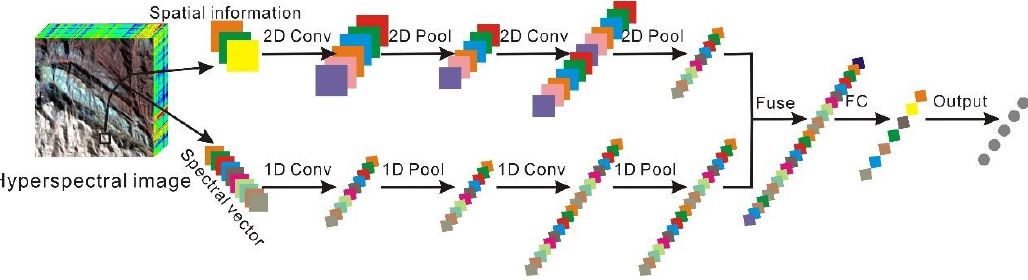
Figure 8. The 1D and 2D CNN structure for hyperspectral remote sensing data classification.